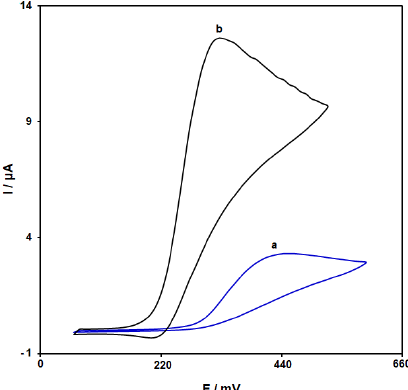
Figure 5. Plot of Ip vs. pH obtained from DPVs of NiCo-MOF/SPGE in a solution containing 100.0